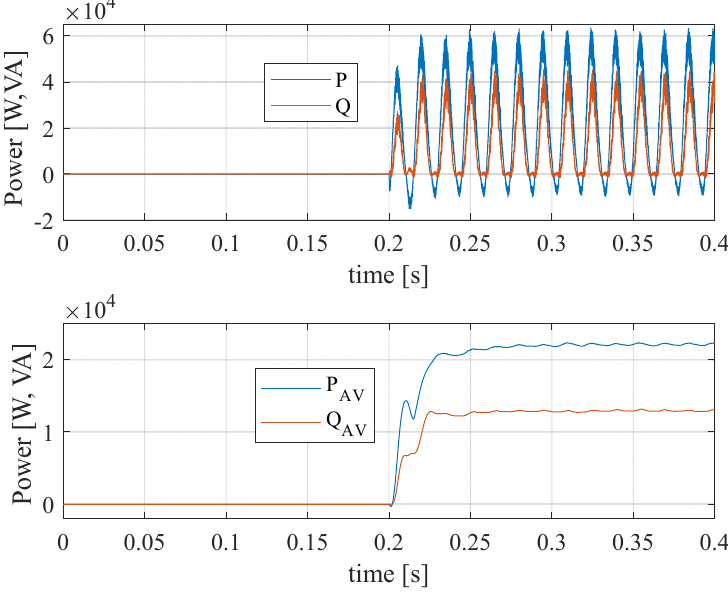
Figure 24. Active and reactive power during parallel cooperation and compensation oscillating torques.